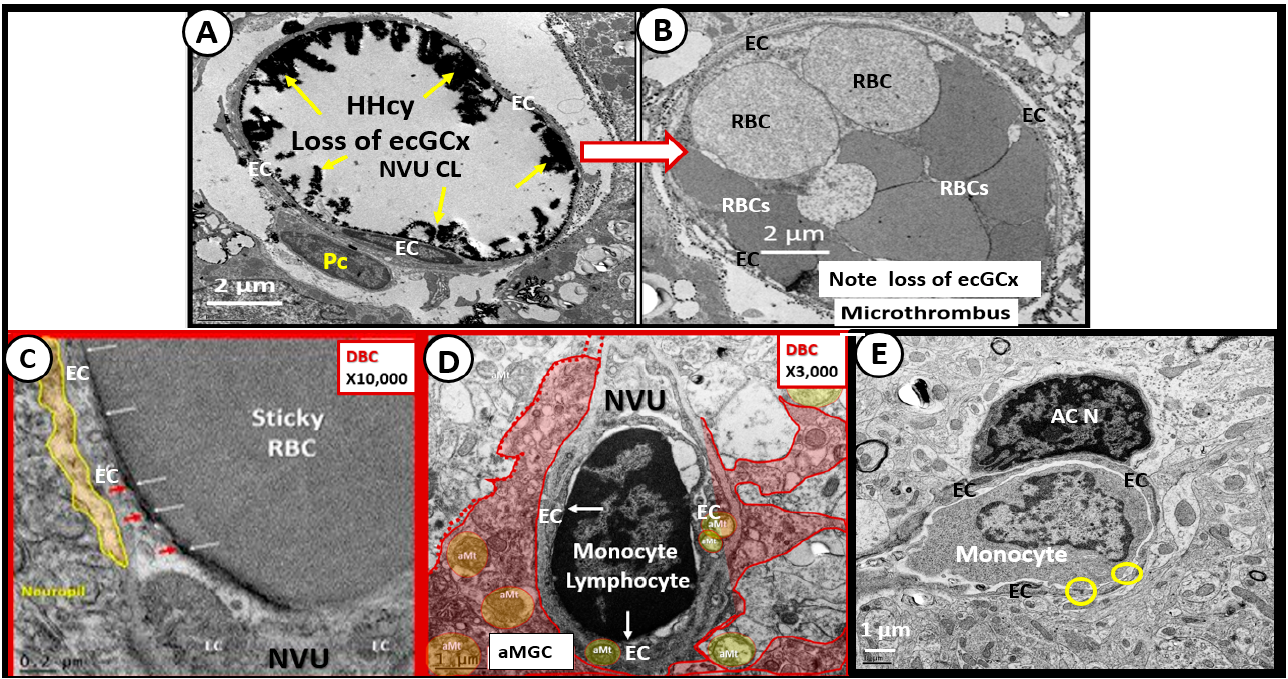
Figure 13. Impaired FOCM and Elevated Hcy (HHcy) Results in an Activated Endothelium that Promotes Activated Fractalkine (CX3CL1). This collection of transmission electron micrographs from the female diabetic db/db models and diabetic BTBR ob/ob models in cortical grey matter (layer III) allow for illustrative and representative images that may also be present in Long COVID/post-acute sequelae of SARS-CoV-2 (LC/PASC). Impaired FOCM is associated with hyperhomocysteinemia (HHcy) and results in an activated endothelium with an attenuation and/or loss of endothelial glycocalyx (ecGCx) (yellows arrows pointing to lanthanum nitrate positively stained ecGCx) in the control model (panel ( A )), which predisposes to the attenuation and/or loss of the ecGCx in diabetic BTBR ob/ob models and the development of microclots and microthrombi (panel ( B )). Additionally, impaired FOCM with HHcy is associated with endothelial activation and dysfunction resulting in adhesion of red blood cell(s) (RBCs) (panel ( C )) and adhesion of leukocytes such as lymphocytes (panel ( D )) and monocytes (which may include the non-classical monocyte (CD14Lo, CD16+) (panel ( E )). Magnifications vary and scale bars are included. This modified multi-panel figure is reproduced with permission by CC 4.0 [6,27,32,41].